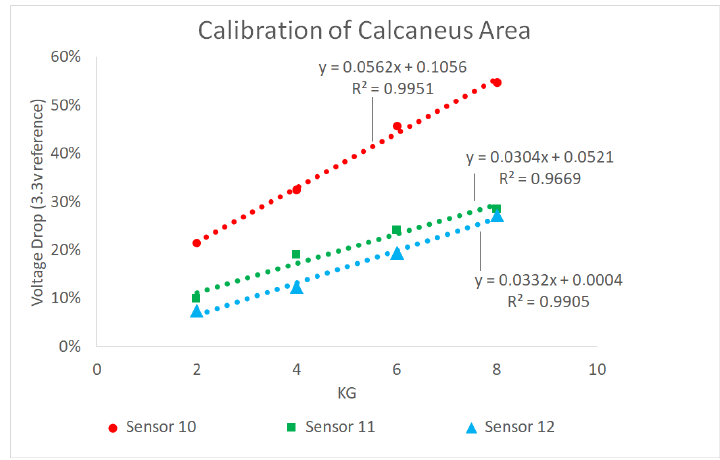
Figure A4. Calibration curve for calcaneal region